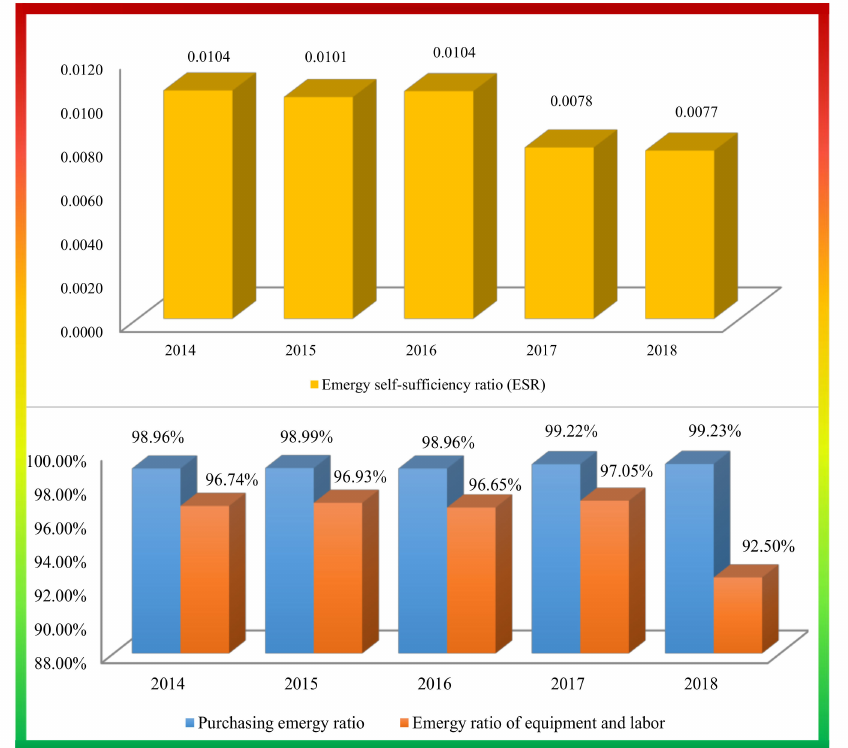
Figure 2. Analysis of emergy structure